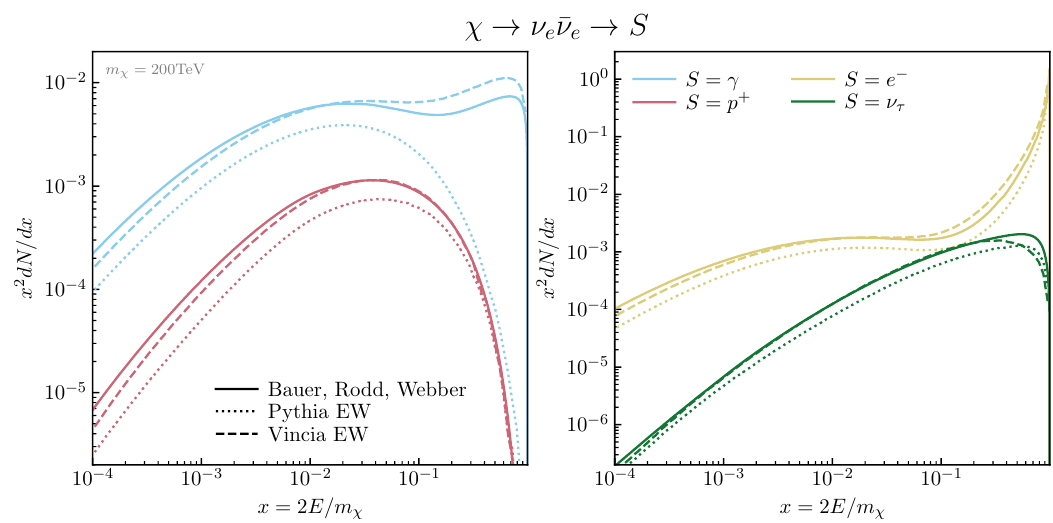
Figure 13: Comparison of the energy spectra of the stable particles γ (blue), p + (red), e − (yellow) and ν τ (green) in the decay χ → ν by Bauer, Rodd and Webber [ 62 ] (solid), Pythia’s EW shower (dotted) and Vincia’s EW shower